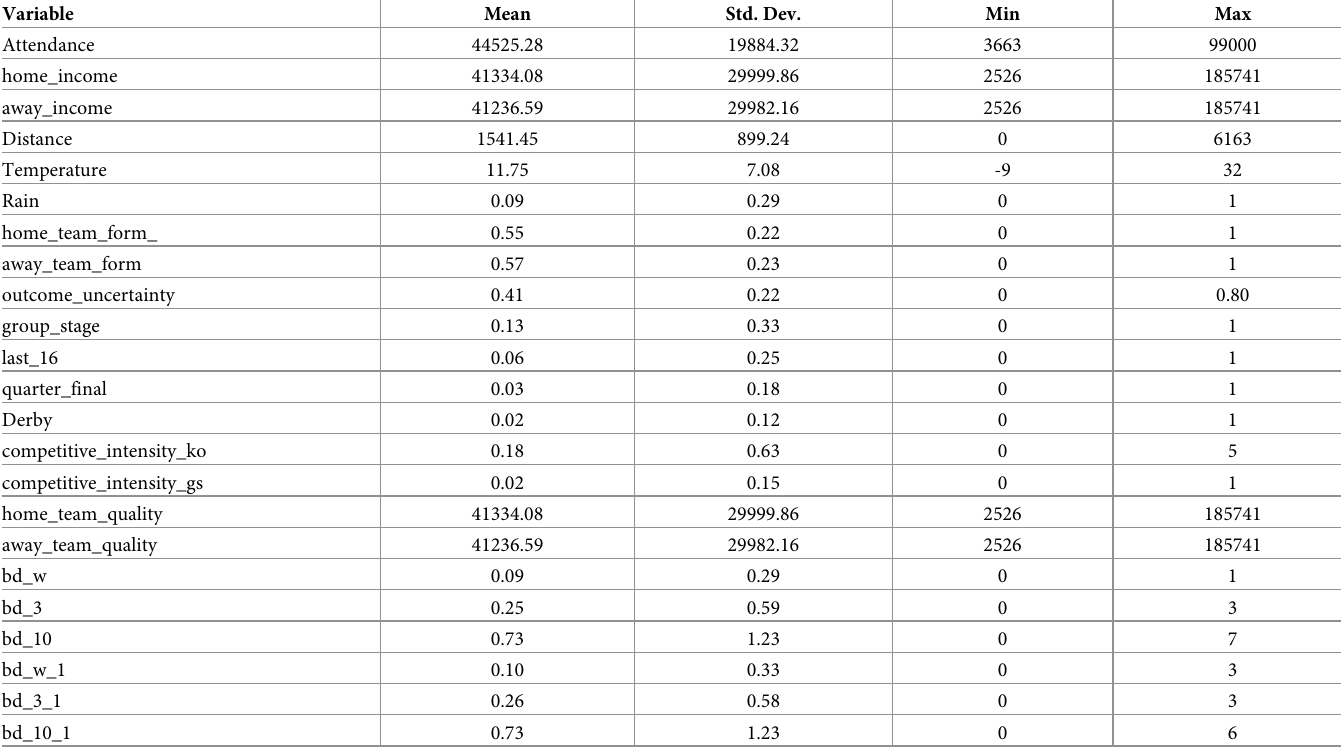
Table 1. Descriptive statistics of dependent and explanatory